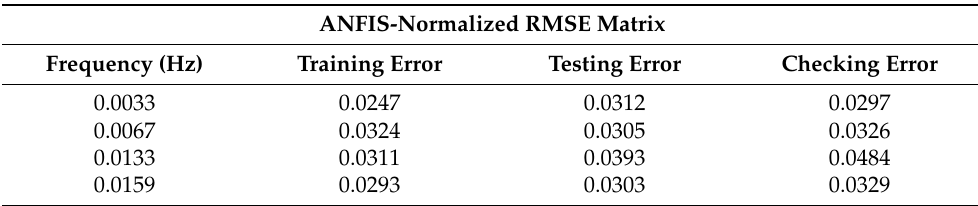
Table 1. ANFIS-normalized RMSE matrix at a voltage input of 0–5 volts and varying frequencies.